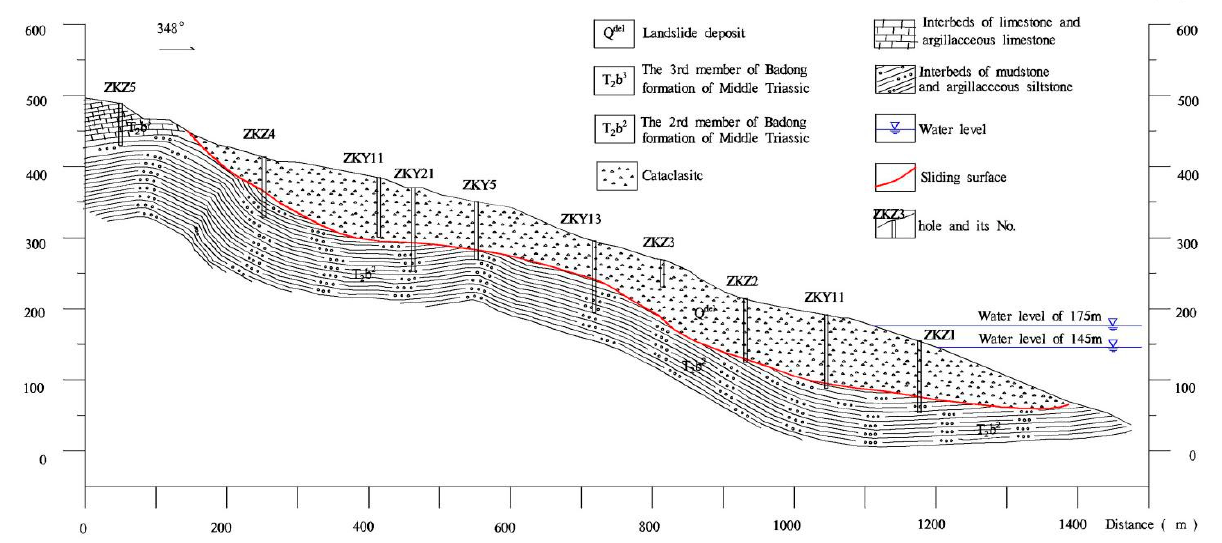
Figure 3. Engineering geological cross-section of the Zhaoshuling Landslide (C-C’).